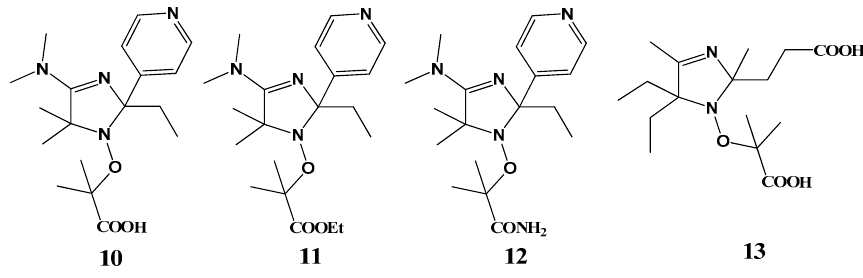
Figure 6. Structures of alkoxyamines 10 – 13 .